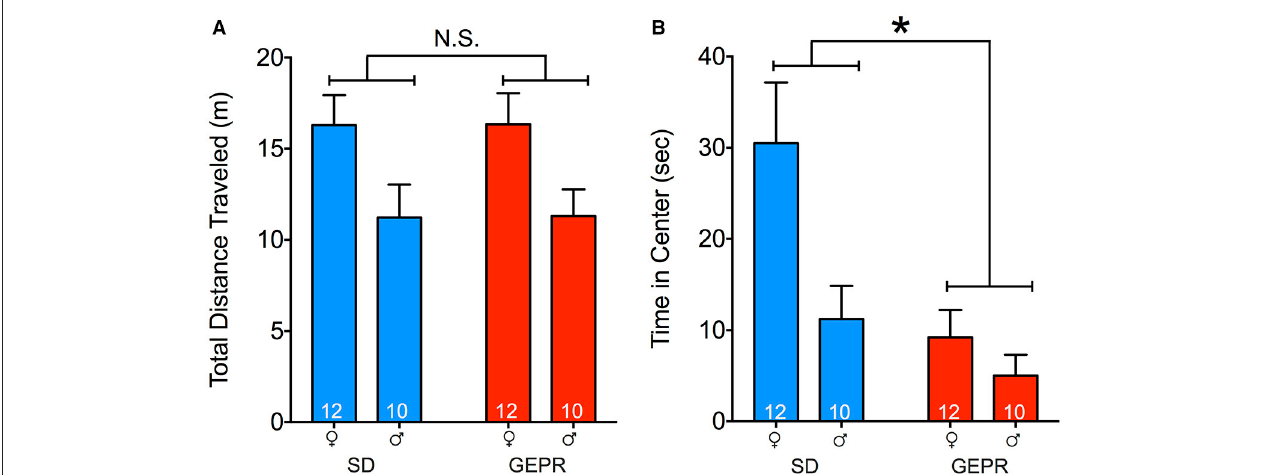
FIGURE 1 | Open field test. (A) Total distance traveled (meters) for the duration of the test (10min); males of both strains explored the arena less than females [ F (1,39) = 9.0, P = 0.005; Holm-Sidak post-tests, Ps < 0.05]. (B) Total time spent exploring the center (8.5 ′′ × 8.5 ′′ ) of the open field. GEPR-3s explored less than SD rats [* F (1,39) = 9.2, P = 0.004], and males explored less than females [ F (1,39) = 6.7, P = 0.01]. Post-tests also showed a decrease in exploration of the center of the arena in female GEPR-3s relative to SD rats (Holm-Sidak corrected, P < 0.05). Figures show mean and standard error of the